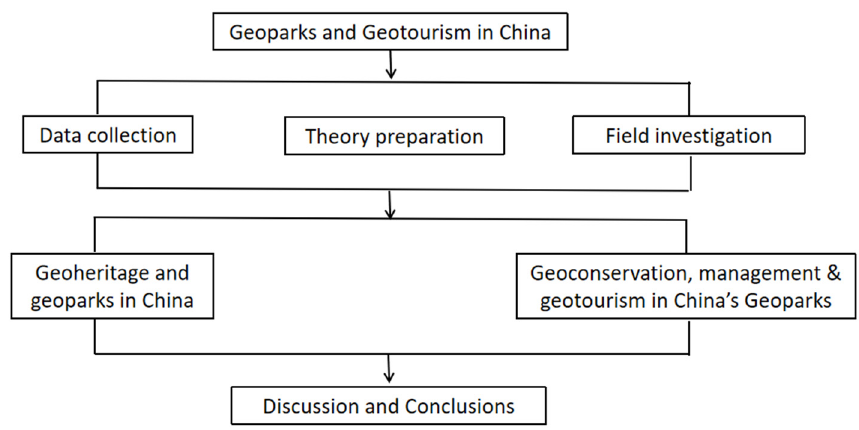
Figure 2. Flow chart of the research framework.